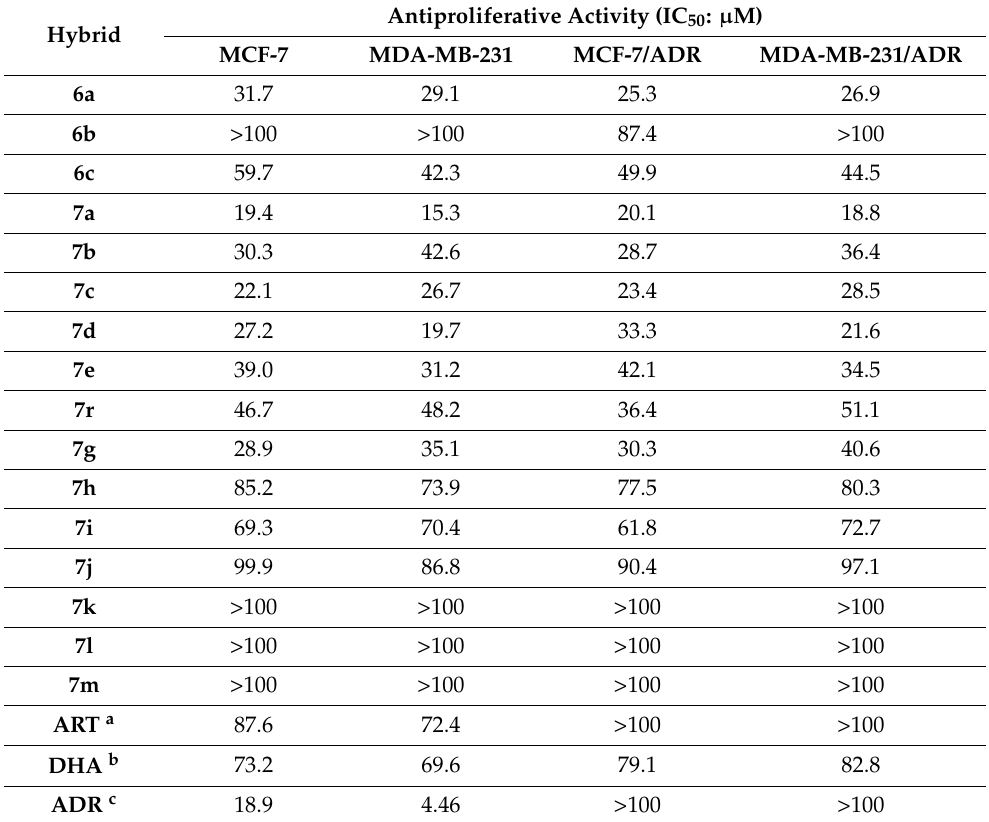
Table 1. The antiproliferative activity of DHA-5-methylisatin hybrids 6a–c and 7a–m .